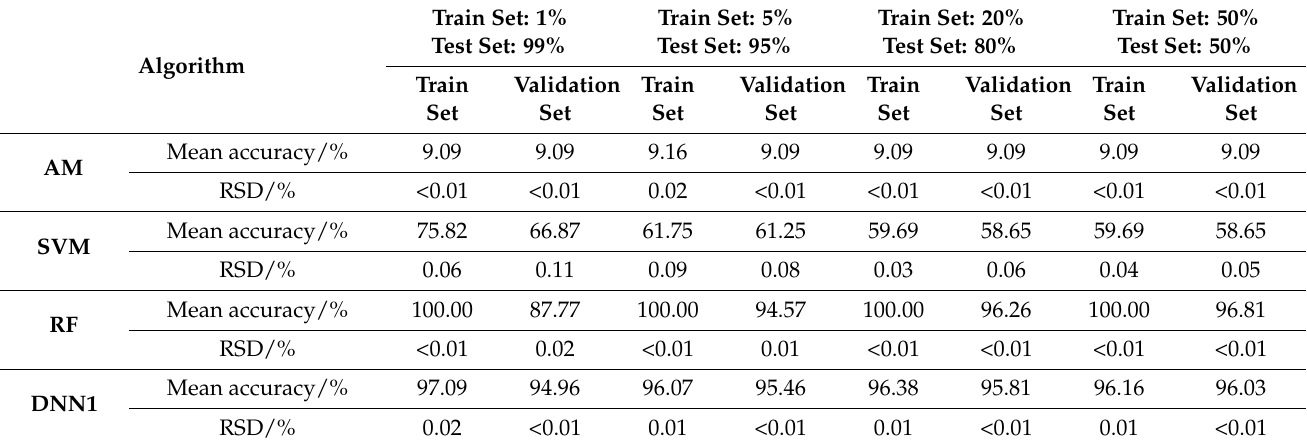
Table 6. Mean and RSD of accuracy using selected lines as inputs and using different machine learning algorithms over 10